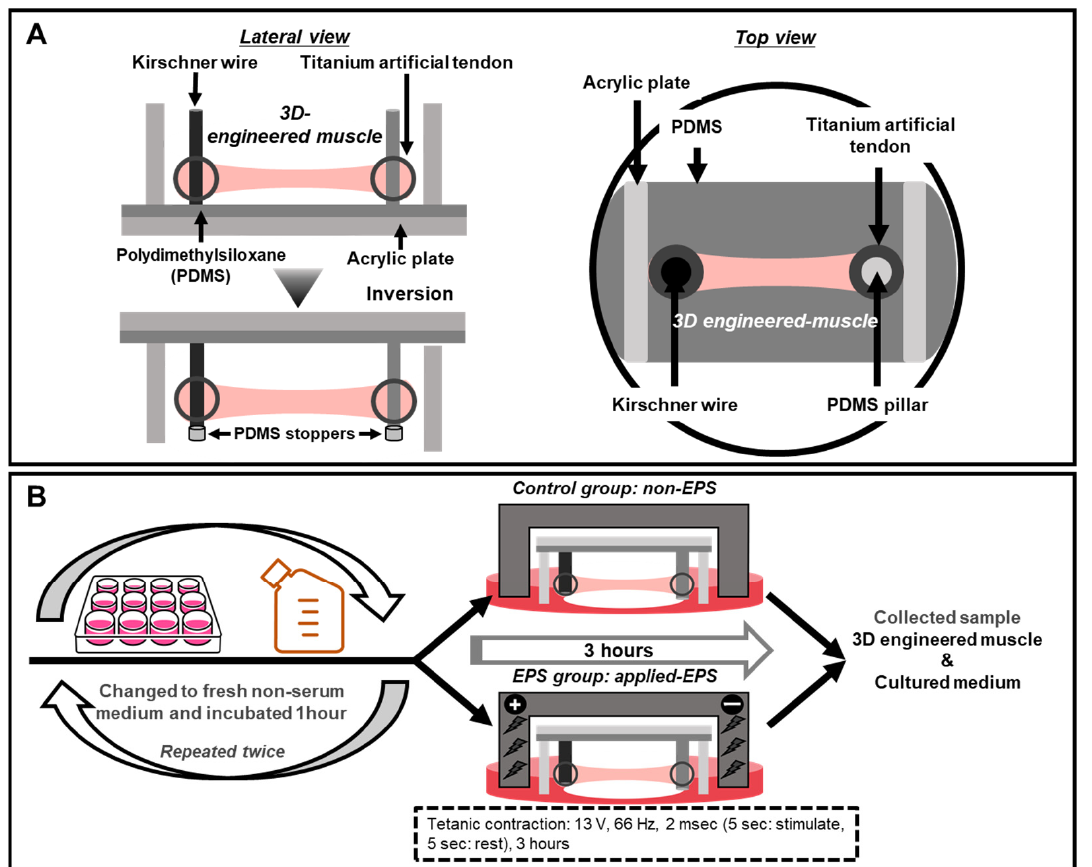
Figure 4. ( A ) A titanium artificial tendon was inserted into each of the Kirschner wires and a PDMS pillar. C2C12 myoblasts were embedded in Cell Matrix Type 1-A at a density of 1.5 × 10 7 cells/mL. A 100 µL gelled cell suspension was seeded between the two artificial tendons. After 10 days